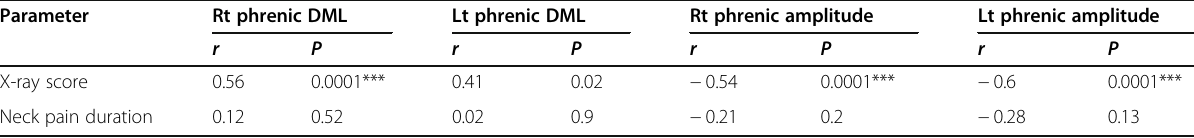
Table 3 Correlation between phrenic DML and some parameters Parameter Rt phrenic DML Lt phrenic DML